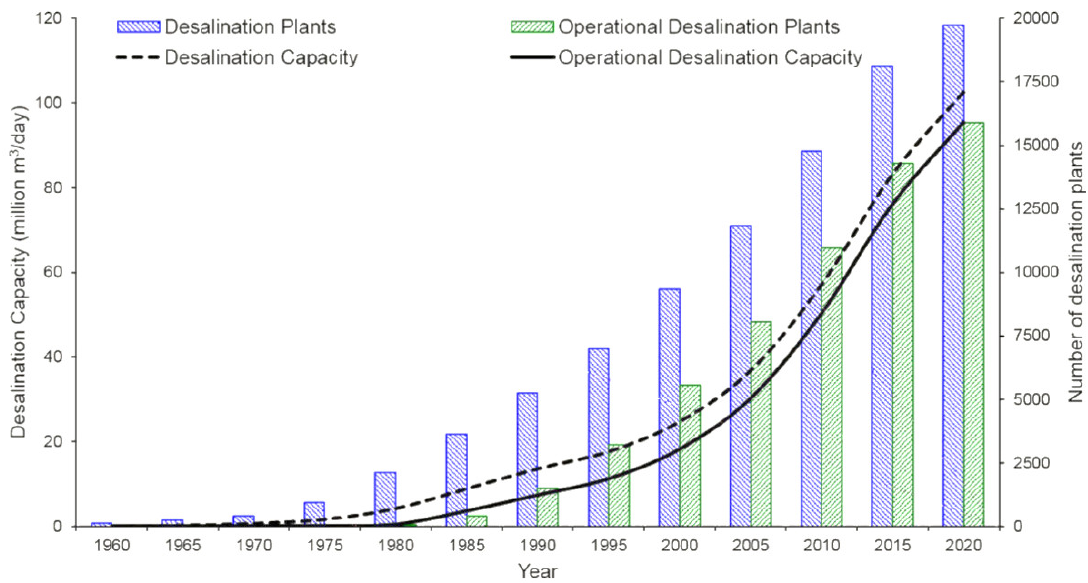
Figure 1. Global desalination growth, 1960–2020. Reprinted figure with permission from [10]. Copyright (2019) Elsevier.